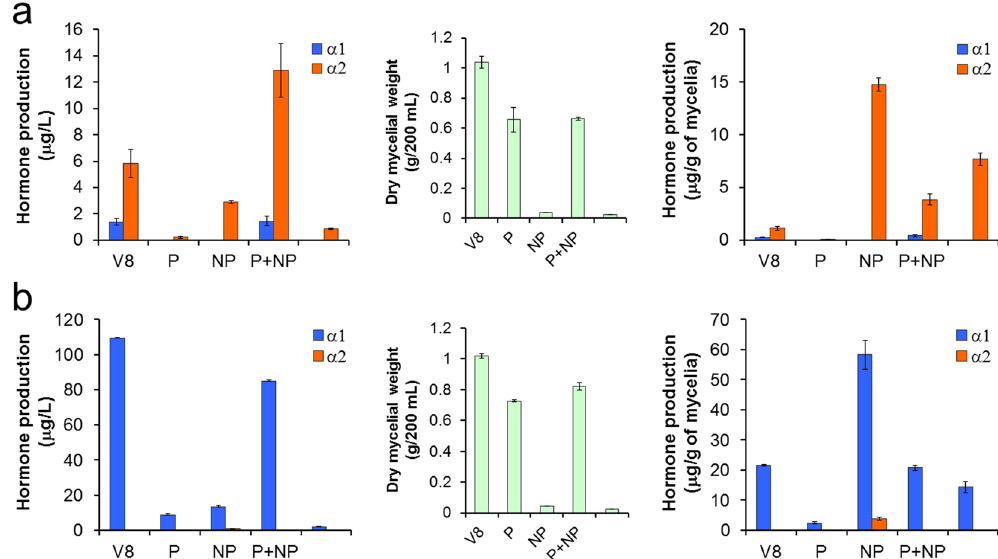
Figure 7. Effect of V8 juice fractions on the mating hormone production. Hormone production of Phytophthora nicotianae NBRC 33190 ( a ) and P. cryptogea NBRC 32326 ( b ). The left, middle, and right graphs show hormone production ( μ g) per broth volume (L), dry mycelial weight (g) per flask (broth volume: 200 mL), and hormone production ( μ g) per dry mycelial weight (g), respectively. V8 indicates 20% V8 vegetable juice medium. P and NP indicate the non-adsorbed (polar) and adsorbed (non-polar) fractions, respectively, in water at a concentration equivalent to 20% V8 juice. No mark indicates the production in only water as a